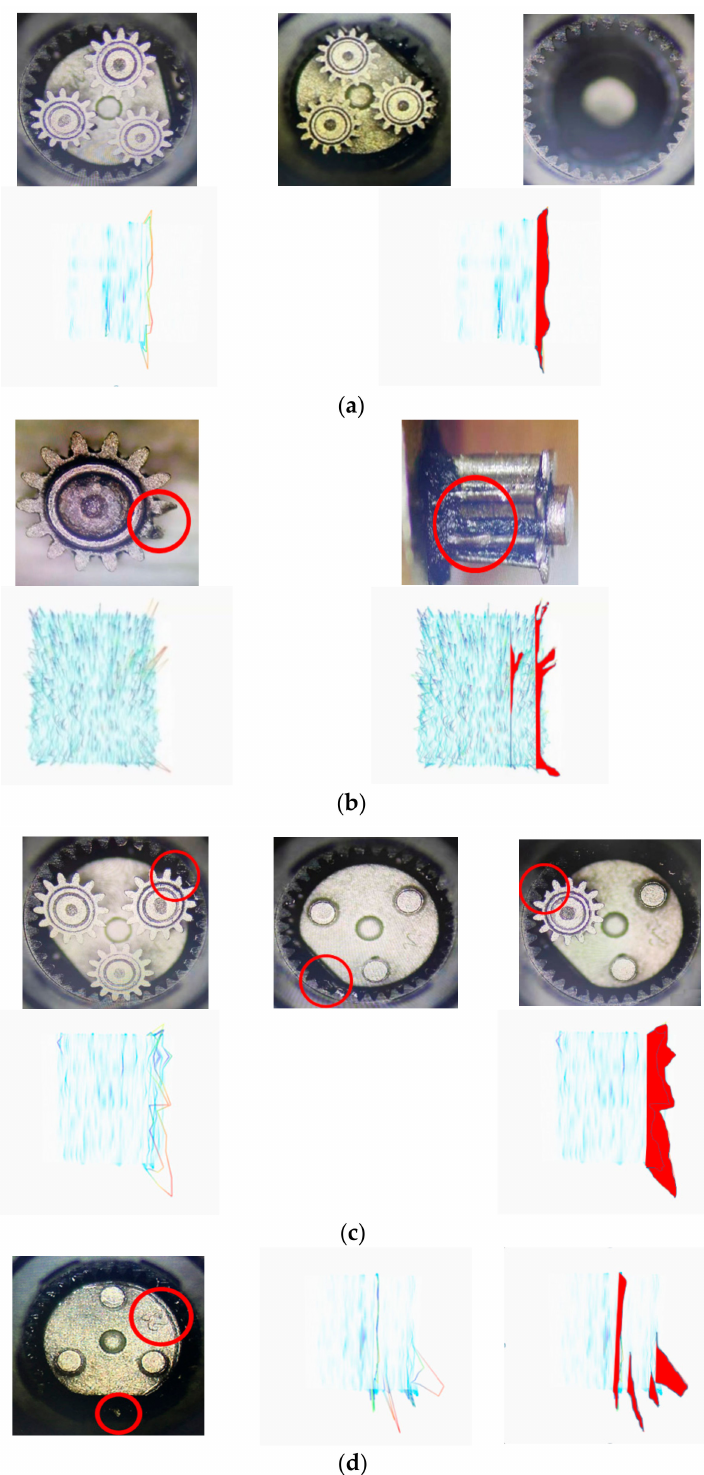
Figure 7. ( a ) The workpiece with normal sound and its characteristic pictures. The first two are inner gear, the second one is outer gear, and both with pure time-frequency spectrum. ( b ) The workpiece with low sound, in the low frequency band there is a noise that is not perceptible to the human. ( c ) The workpiece with collision sound. The main features are covered by the collision features. ( d ) The workpiece containing noise